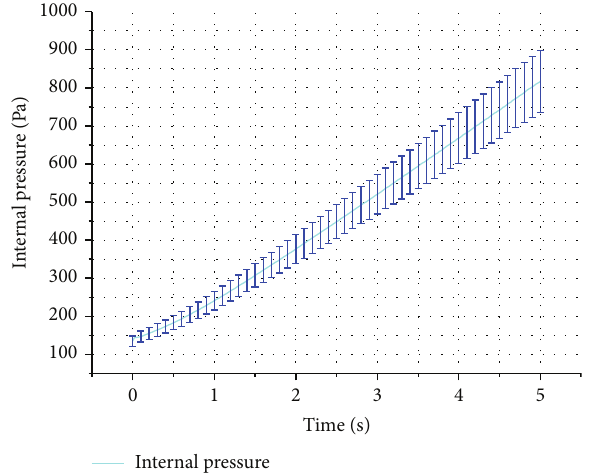
Figure 18: Internal pressure trend, 100Pa 100 Pa/s cold experi- ment points C-F.